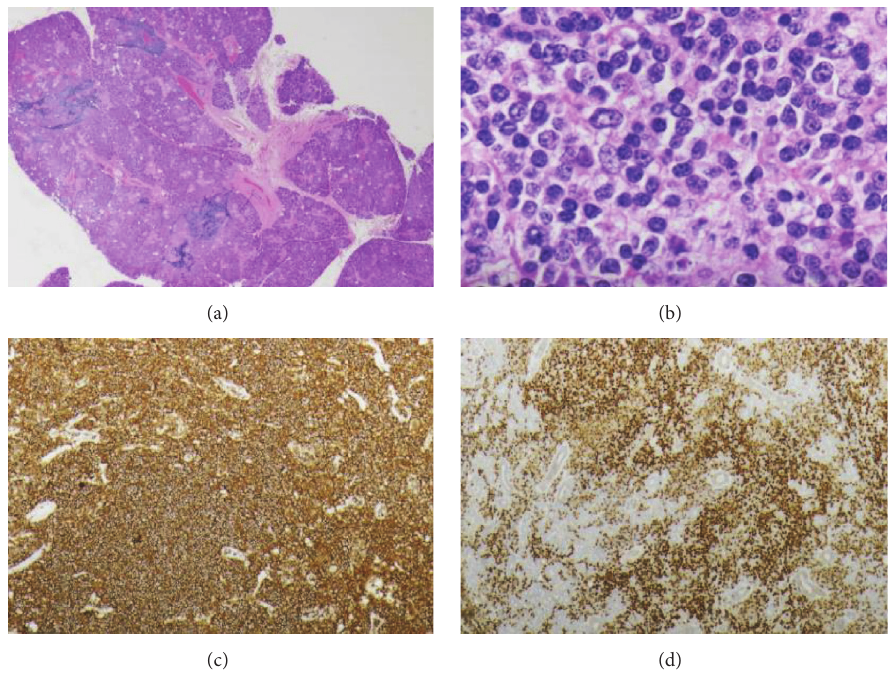
Figure 3: Pathology demonstrated moderate to marked atypical small lymphoid proliferation, involving the parotid gland parenchyma and ducts, composed of predominantly small lymphoid cells on low-power (a) and high-power (b) H&E. Immunohistochemistry demonstrated that the B cells were positive for CD20 (c) and PAX 5 (d), consistent with a MALT.